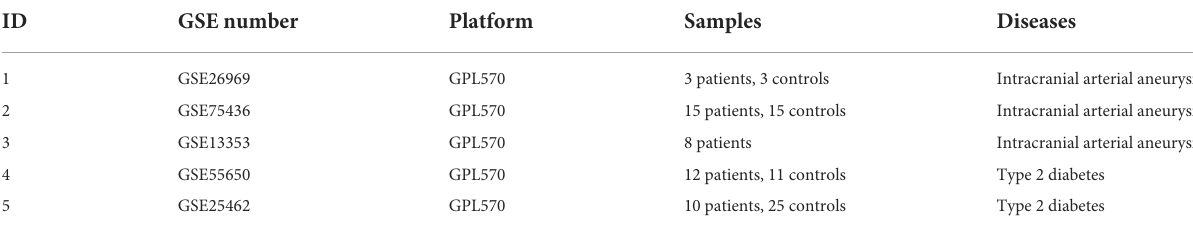
TABLE 1 Sources of data related to intracranial aneurysms and